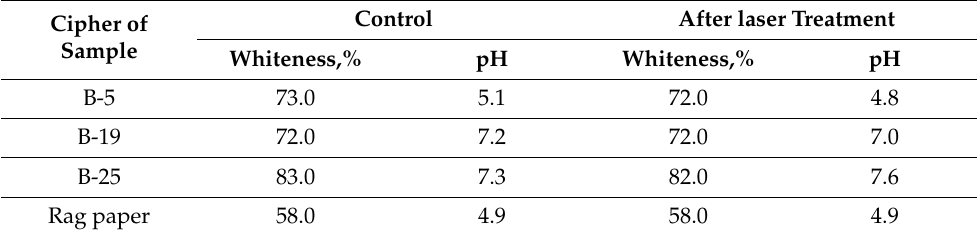
Table 3. The effect of laser treatment on the whiteness of the paper and the value of the acidity index (pH).